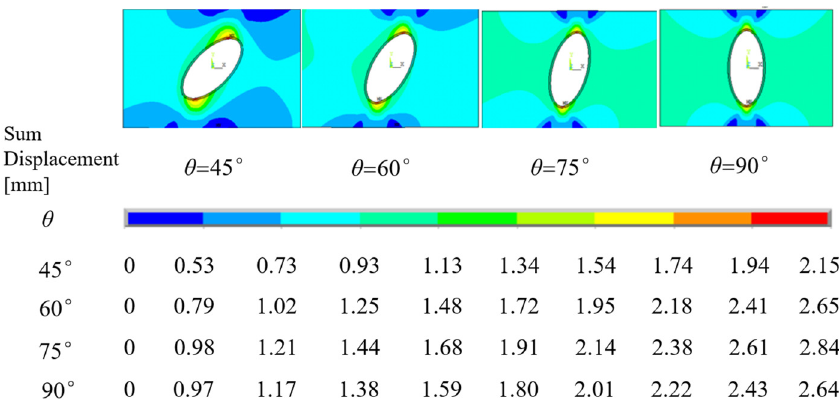
Figure 14: Displacement distribution of the perforated plates with t = 8 mm in the ultimate